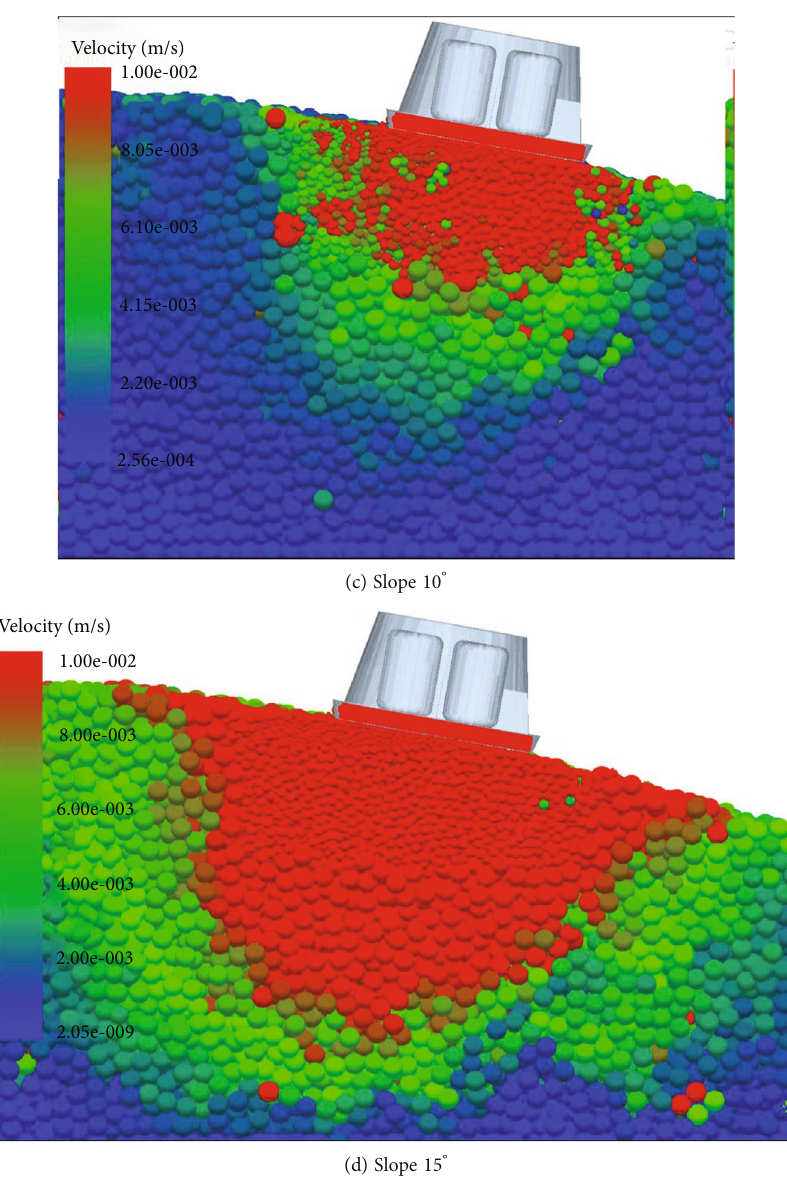
Figure 22: Simulation results of landing bu ff er under di ff erent slope